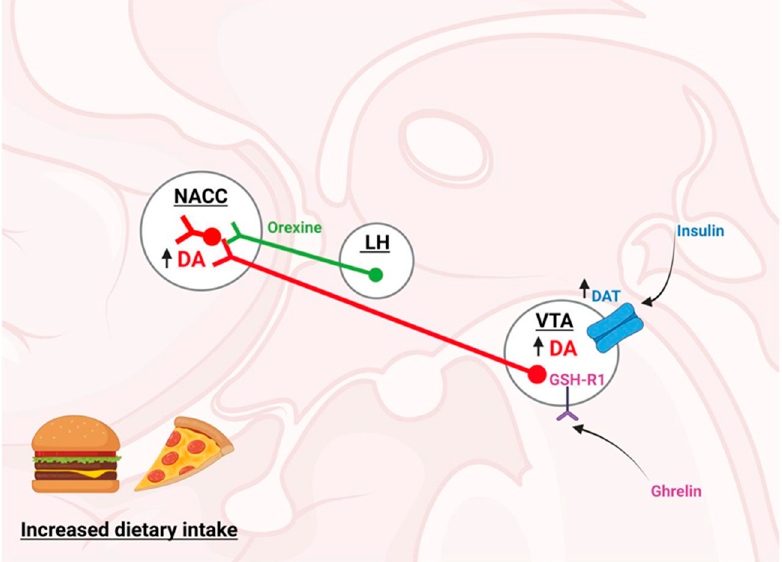
Figure 2. The hedonic control system of feeding. Dietary intake is associated with increased dopamine (DA) availability, mediated by the activation of the secretagogue hormone receptor type 1 (GSH-R1) in the ventral tegmental area (VTA) by ghrelin, thus directly stimulating dopaminergic neurons and their terminals in the nucleus accumbens (NAcc), leading to increased DA release. DA is also re-uptaken in the VTA through dopamine transporter (DAT) phosphorylation, which is increased by the effect of insulin. Finally, it is worth mentioning that the orexigenic neurons of the LH that produce orexin (hypocretin) project their axons on to the VTA, activating the dopaminergic neurons and, consequently, increasing the availability of DA in the environment. This figure was created with BioRender.com under a subscription and has a license from BioRender to use the figure in journal publications.